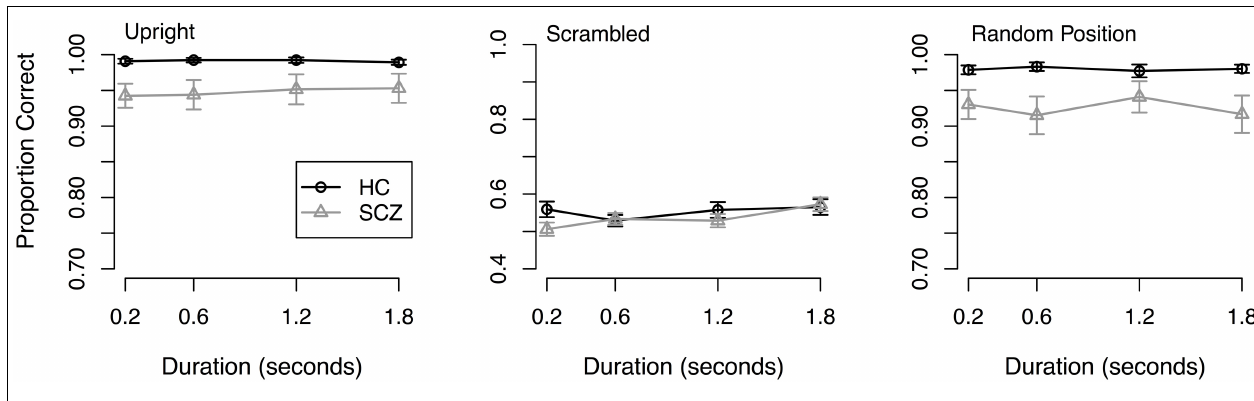
FIGURE 3 | Response accuracy from Experiment 3. Both groups of participants showed better performance in the upright and random position conditions compared to the scrambled condition. No interactions were found.